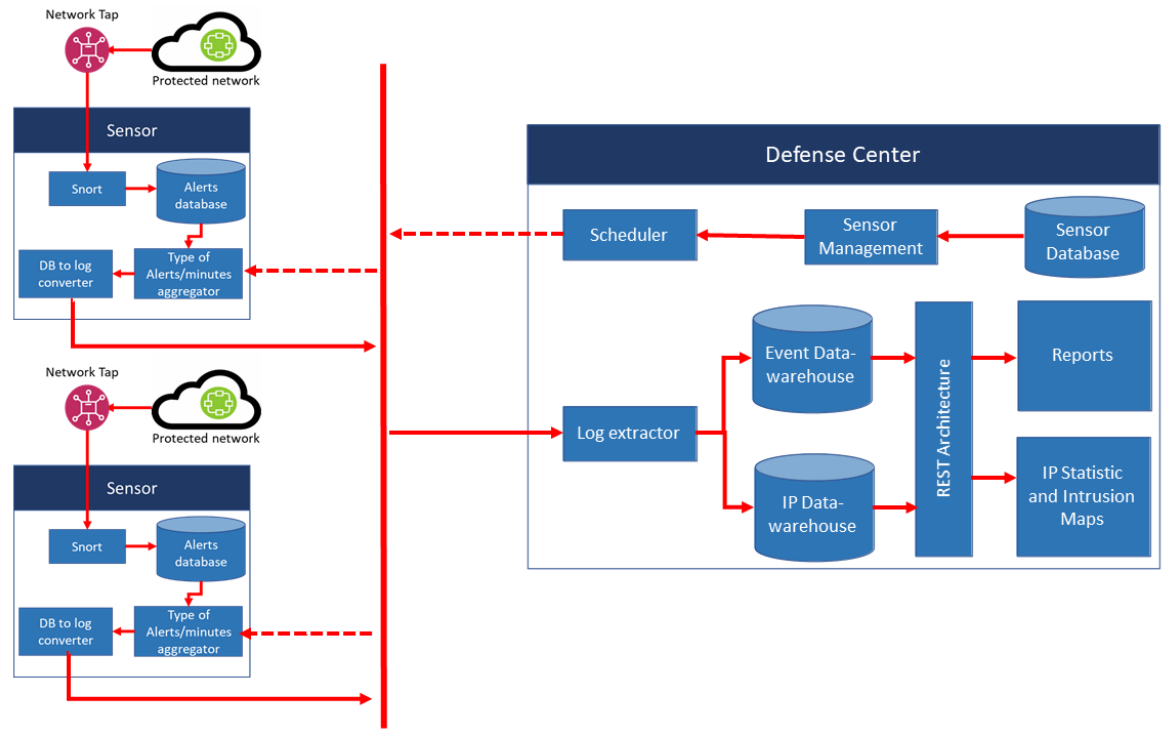
Figure 2. Mata Garuda with distributed database (2015).